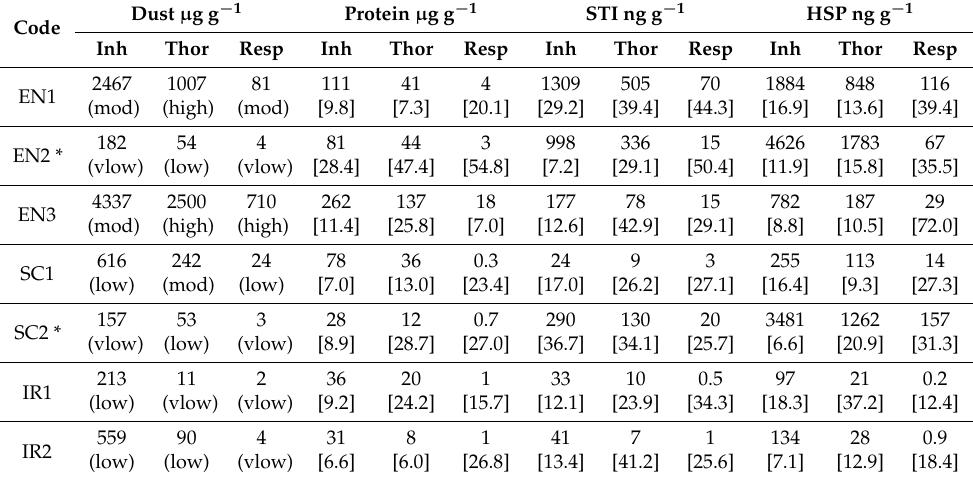
Table 2. Mean outcomes from drum dustiness. Results are expressed per g of bulk